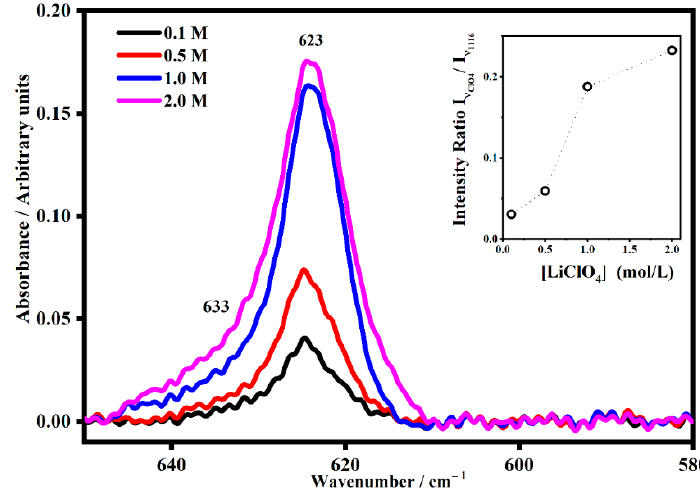
Figure 13. The IR band assigned to the ClO 4 − anion I ν ClO4 (~623 cm − 1 ) and its satellite band at I ν ClO4* (~633 cm − 1 ) in PMMA-Li-PC gel polymer electrolyte at different salt concentrations: 0.1 M, 0.5 M, 1 M and 2 M. In the inset, the Intensity Trend of the band at 623 cm − 1 as a function of the salt concentrations for the PMMA-Li-PC polymeric blend system. The band at 623 cm − 1 , assigned to the free anion, was normalized by the intensity band at 1116 cm − 1 , which does not depend by the lithium perchlorate concentration.